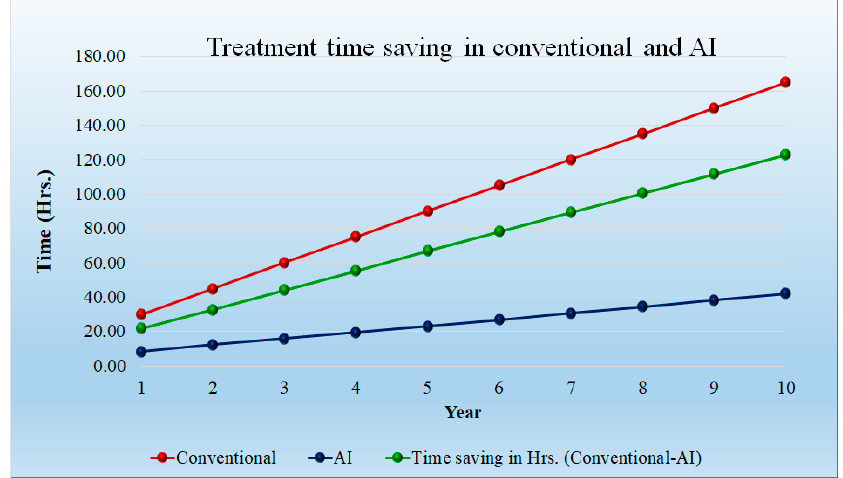
Figure 14. Treatment time ‐ saving (green). Conventional time (red) and AI time (blue).